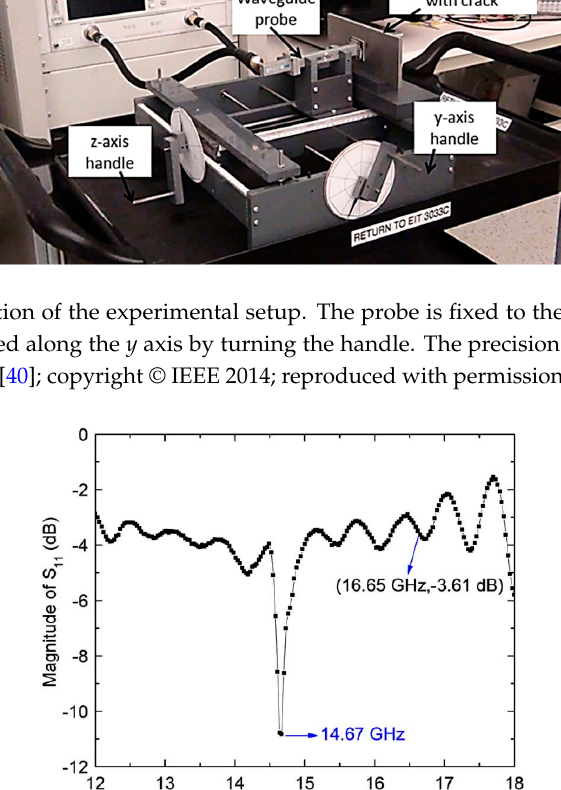
Figure 25. Experimental results for the frequency response of the waveguide probe without the aluminum plate (from [40]; copyright © IEEE 2014; reproduced with permission).